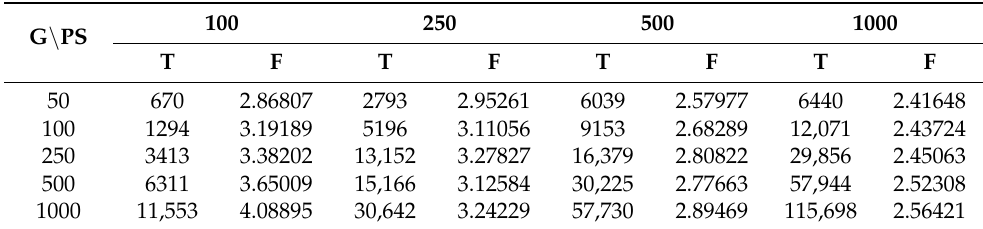
Table 8. Results of population size and generation number simulation (time (T) in milliseconds, fitness value